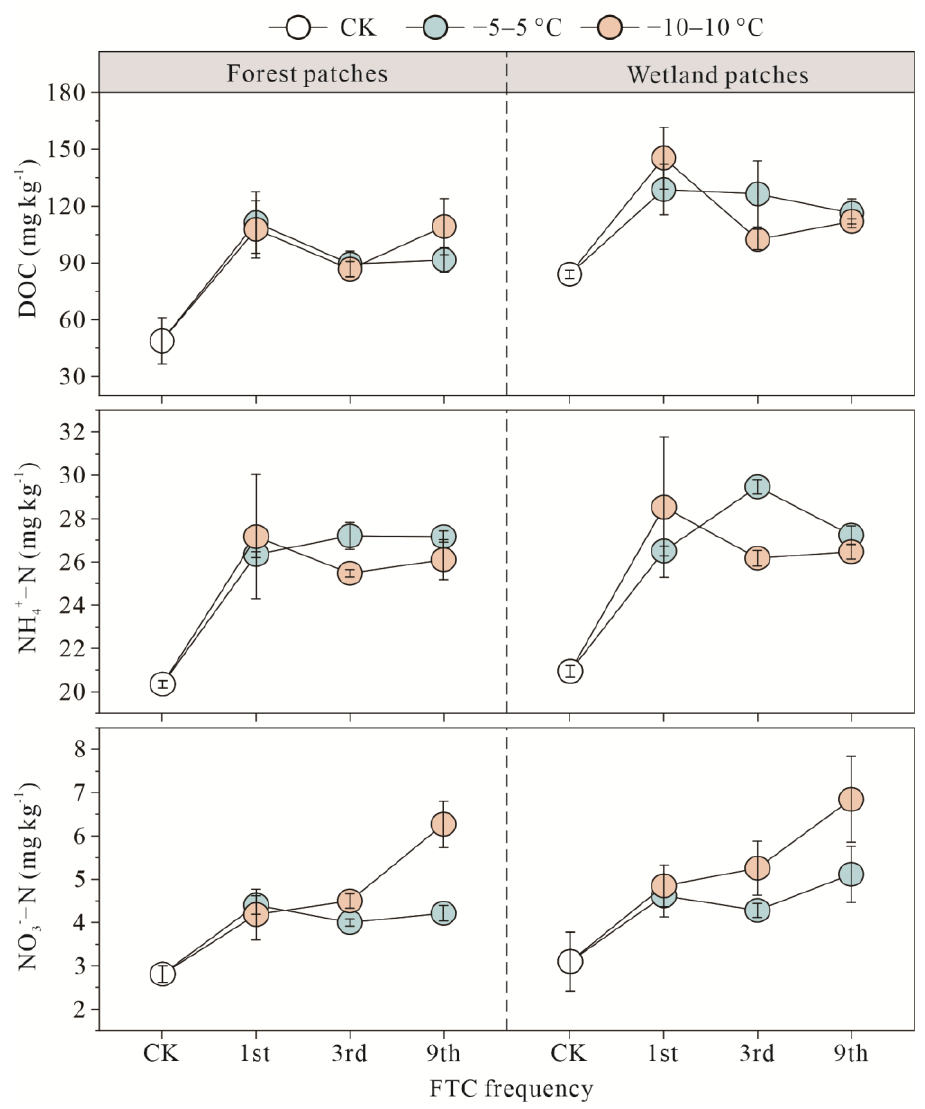
Figure 7. Effects of FTCs on soil DOC, NH 4+ -N, and NO 3 − -N contents.